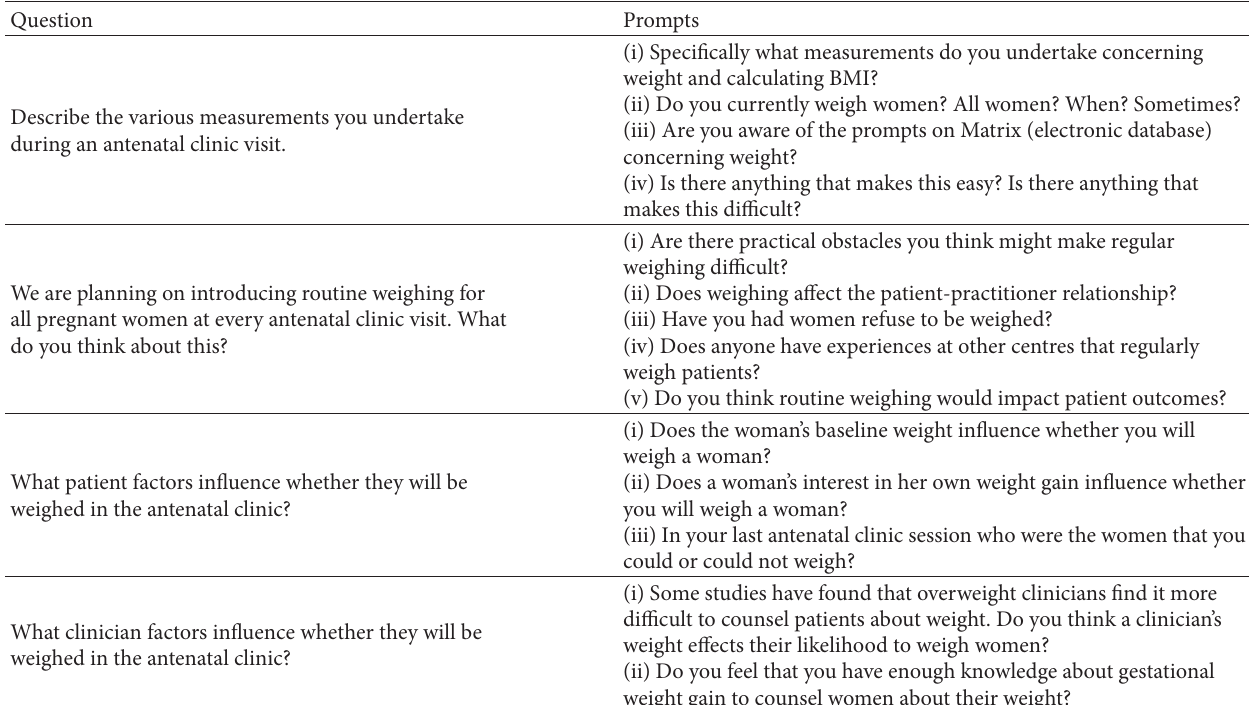
Table 1: Interview topic